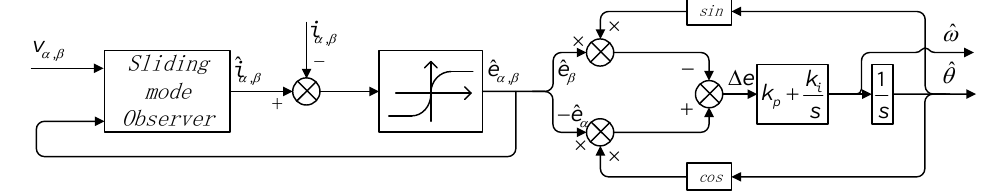
Figure 5. Improved sliding mode observer (SMO) flow chart.